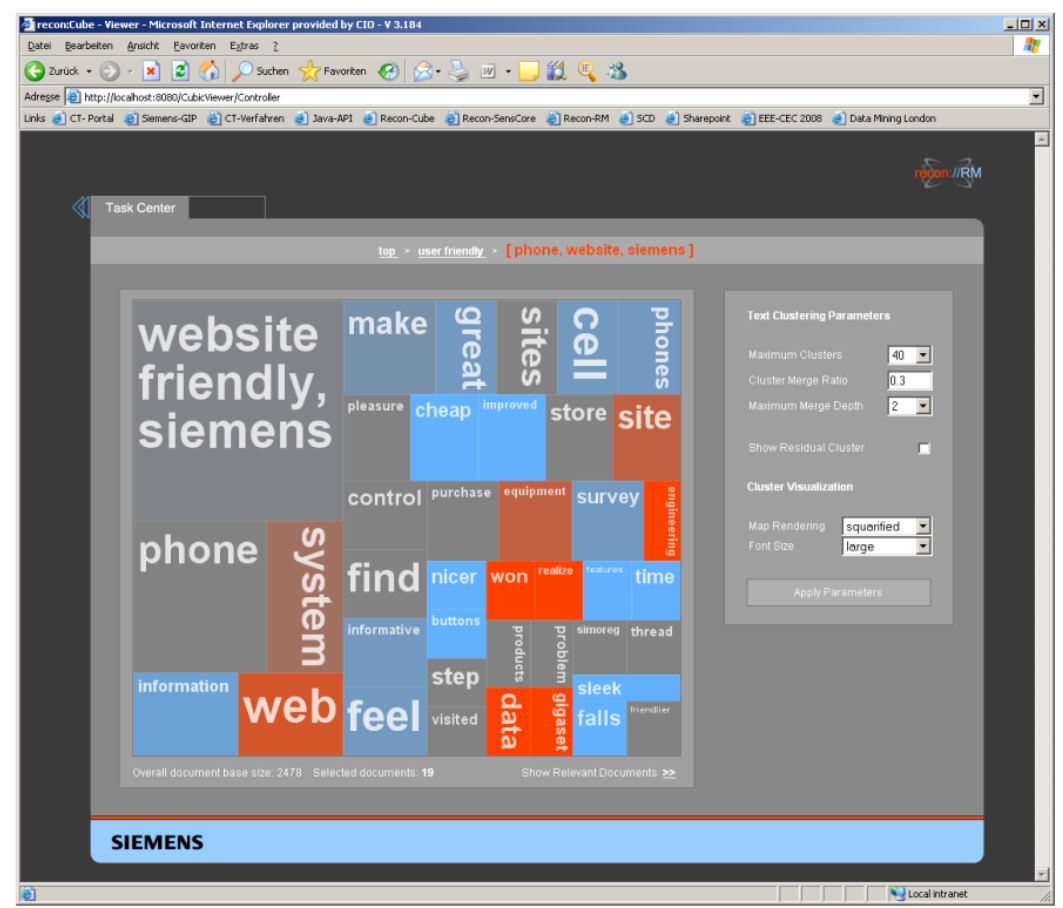
Figure 25. The treemap visualisation of the textual clusters. On the right are the treemap user options that modify the parameters of the treemap generation. The colour of each node represents the positive or negative sentiment of the customers. Image courtesy of Ziegler et al.